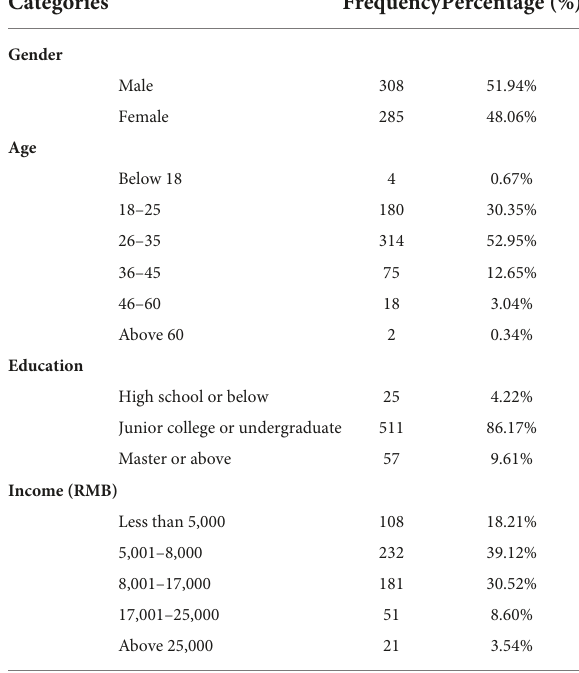
TABLE 1 Respondents’ demographic information ( n =